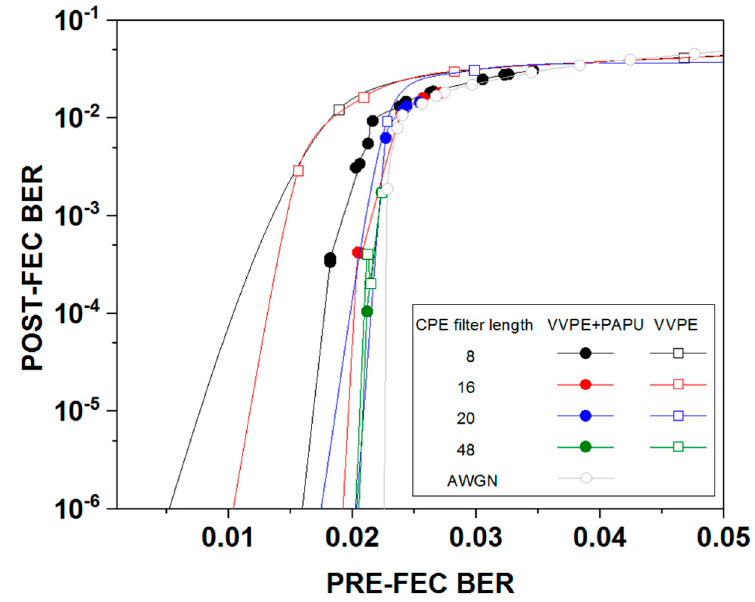
Figure 7. The relationship between POST-FEC BER and PRE-FEC BER.